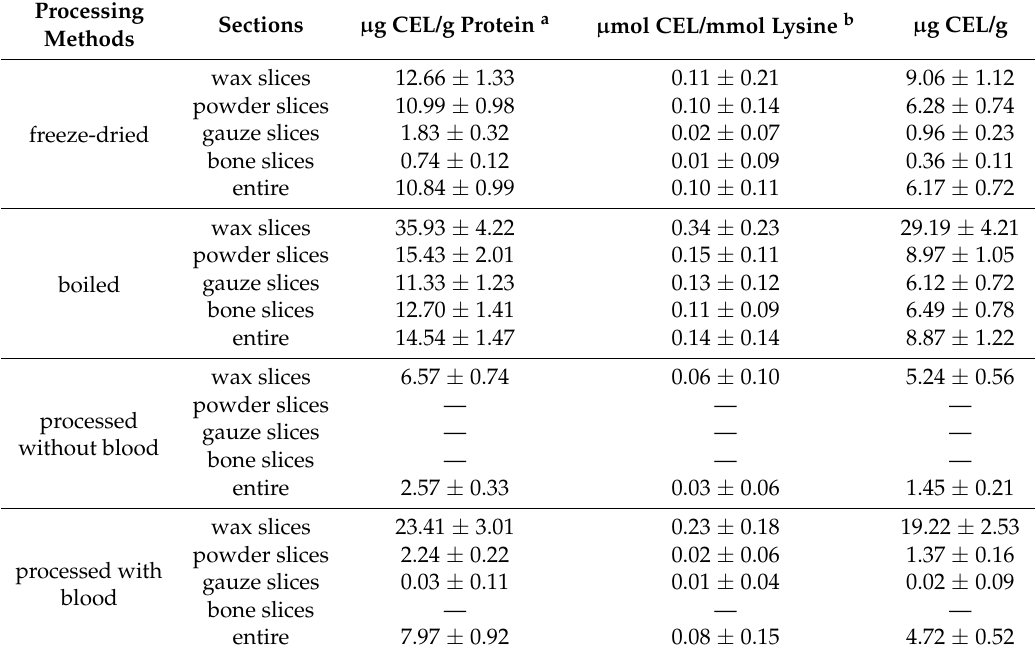
Table 3. CEL contents in different sections of antler velvet with different processing